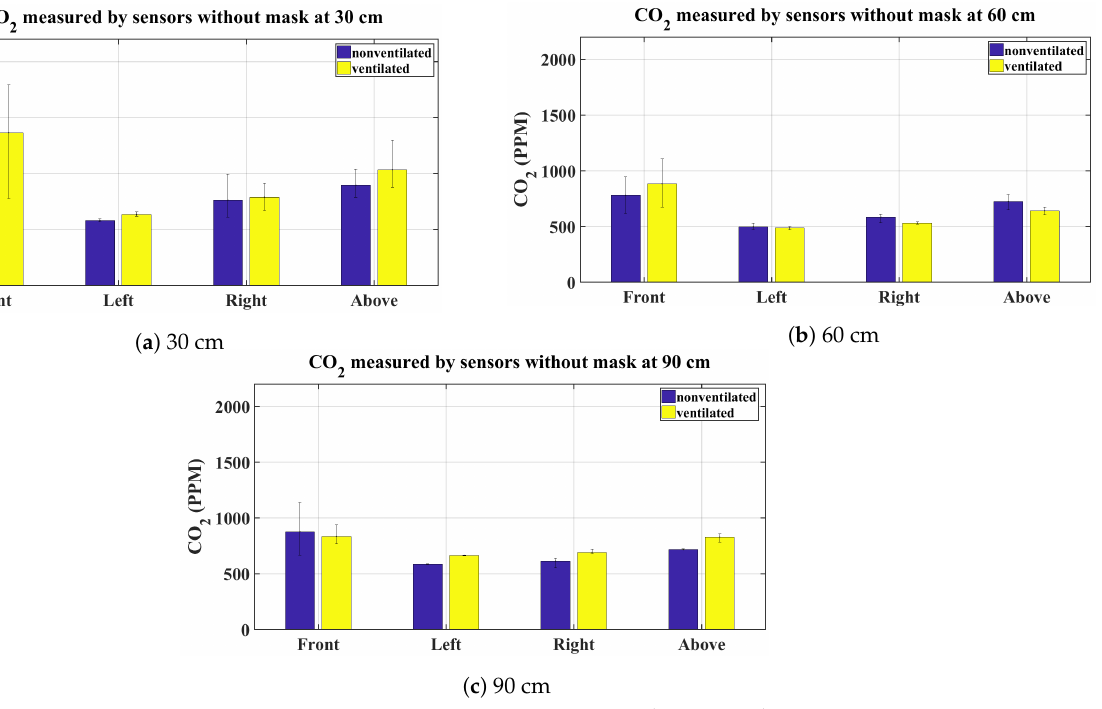
Figure 7. Average CO 2 measurements without a